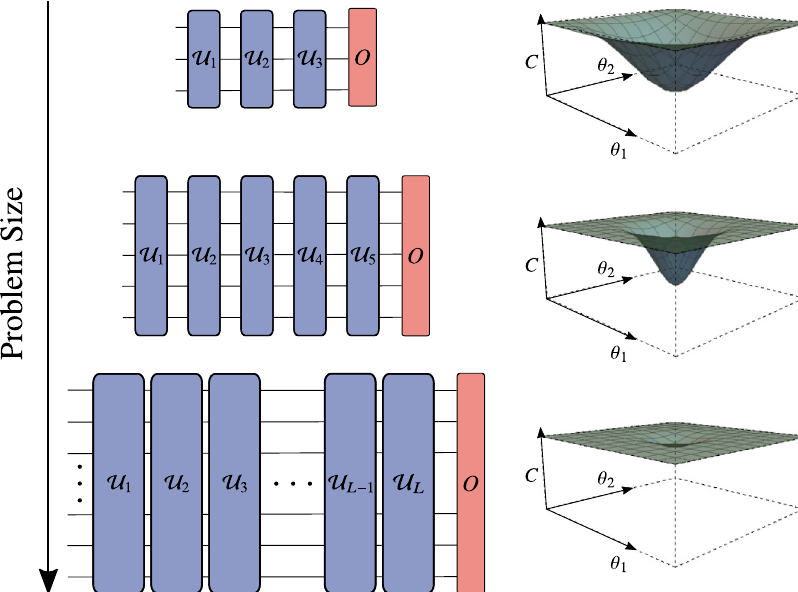
Fig. 1 Schematic diagram of the Noise-Induced Barren Plateau (NIBP) phenomenon. For various applications such as chemistry and optimization, increasing the problem size often requires one to increase the depth L of the variational ansatz. We show that, in the presence of local noise, the gradient vanishes exponentially in L and hence exponentially in the number of qubits n when L scales linearly in n . This can be seen in the plots on the right, which show the cost function landscapes for a simple variational problem with local noise.